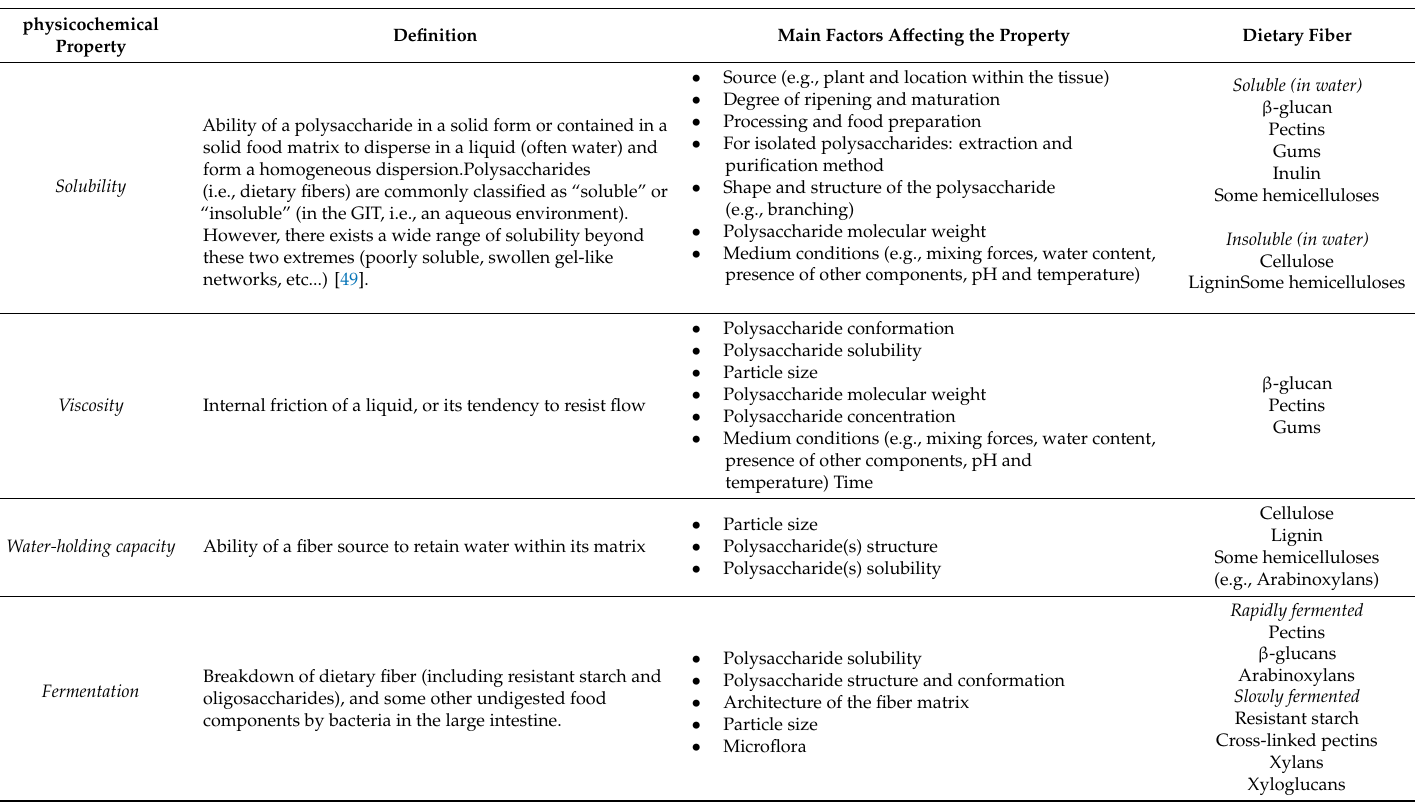
Table 1. Main physicochemical properties of plant cell walls and their polysaccharides that may impact nutrients bioaccessibility and digestibility. Adapted from